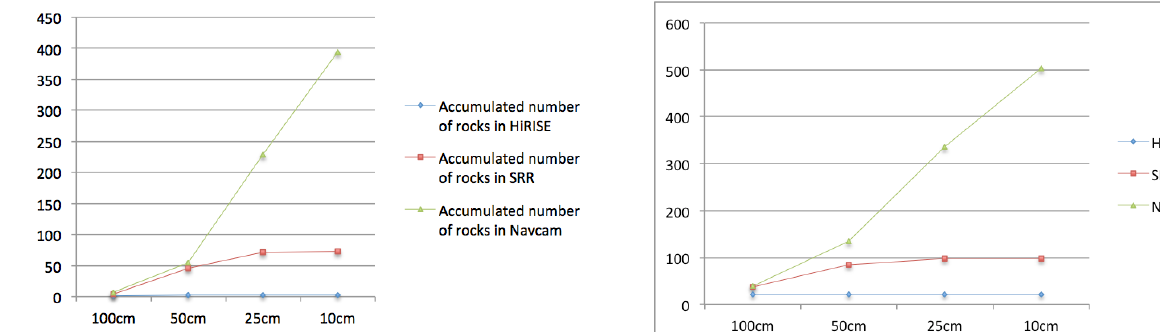
Figure 14 Accumulated rock number-size distribution for HiRISE, SRR, and Navcam at Sol 549.